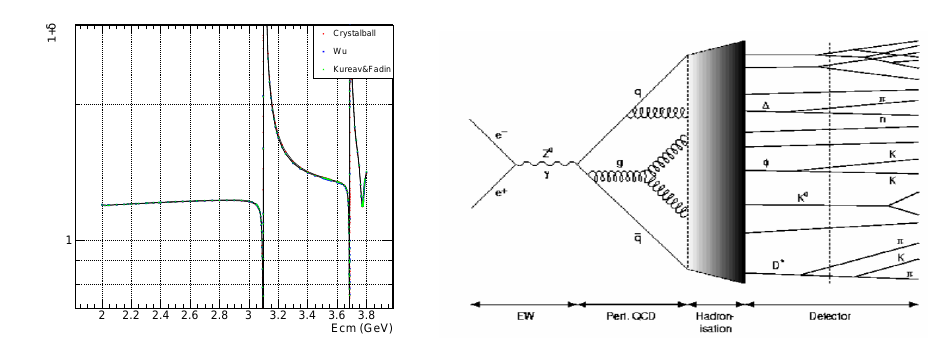
Figure 2. Left: the ISR correction factor (1 + δ ) calculated by Feynman diagram scheme (Crystalball) and structure function schemes (KureavFadin,Wu). Right: the picture of e + e − annihilation into hadrons.